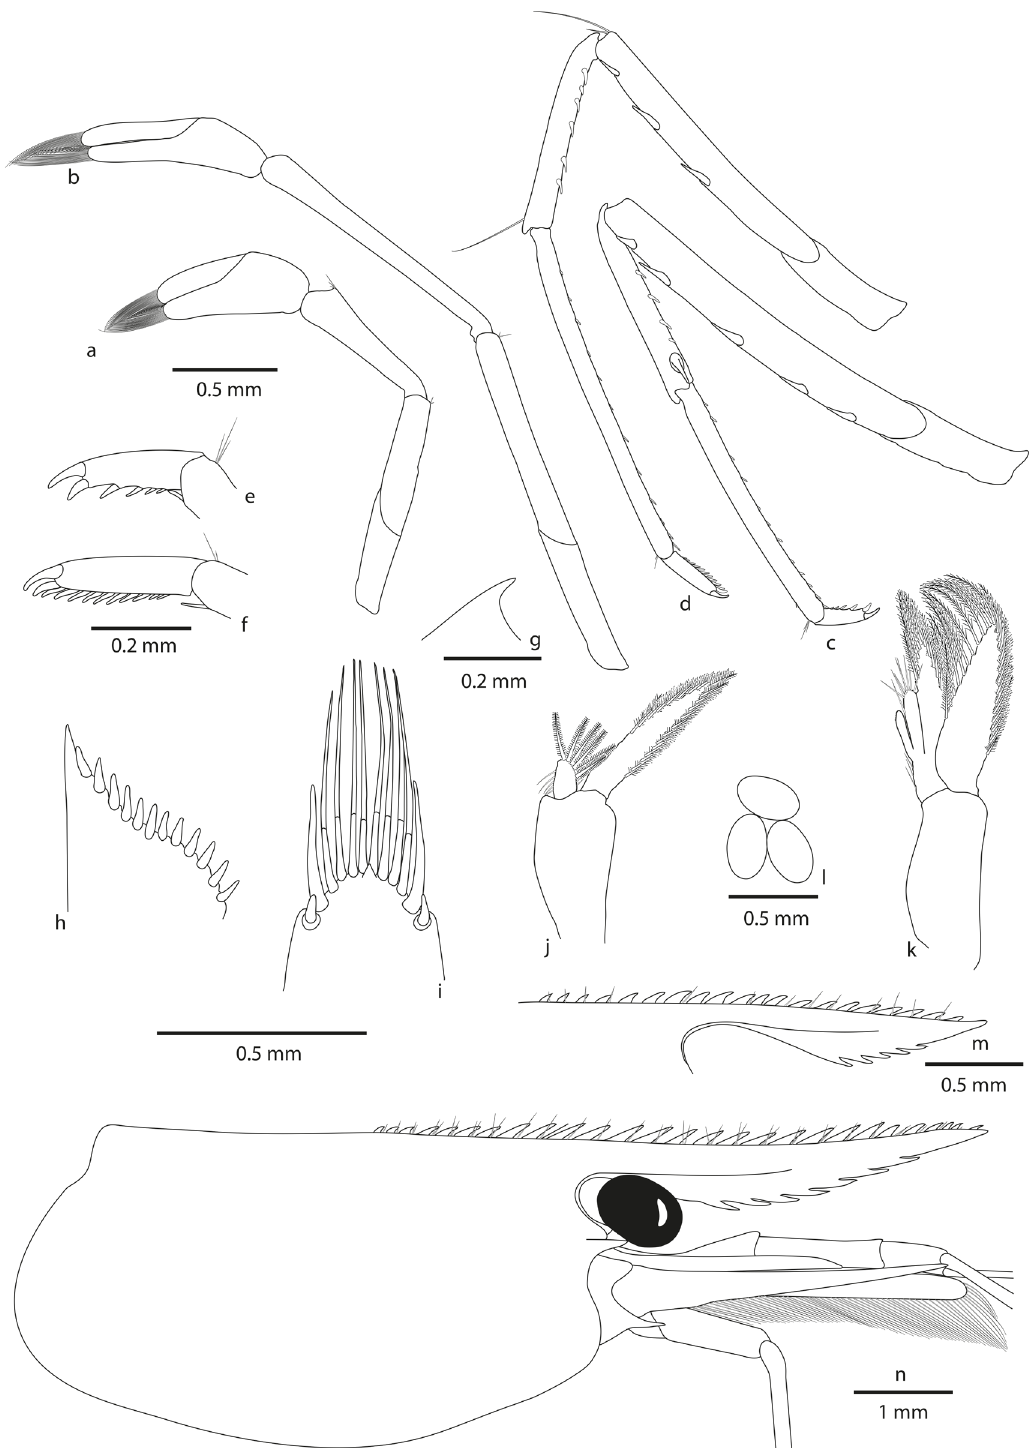
Fig. 23. Caridina serratirostris De Man, 1892. a . First pereiopod. b . Second pereiopod. c . Third pereiopod. d . Fifth pereiopod. e . Dactylus of third pereiopod. f . Dactylus of fifth pereiopod. g . Pre- anal carina. h . Uropodal diaeresis. i . Telson. j . First male pleopod. k . Second male pleopod. l . Eggs. m . Rostrum variation. n . Cephalothorax. MNHN-IU-2018-2928 (a–i, l), MNHN-IU-2018-2933 (j–k, m) and MNHN-IU-2018-2927